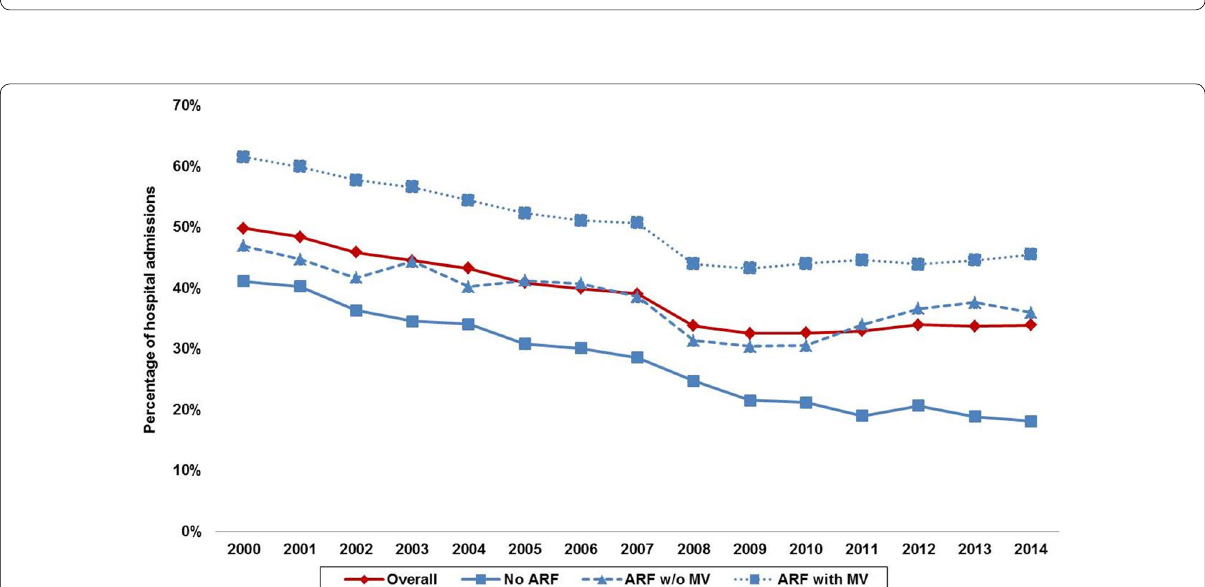
Fig. 3 Trends of in-hospital mortality in AMI-CS stratified by ARF and MV. All p < 0.001. AMI acute myocardial infarction, ARF acute respiratory failure, CS cardiogenic shock, MV mechanical